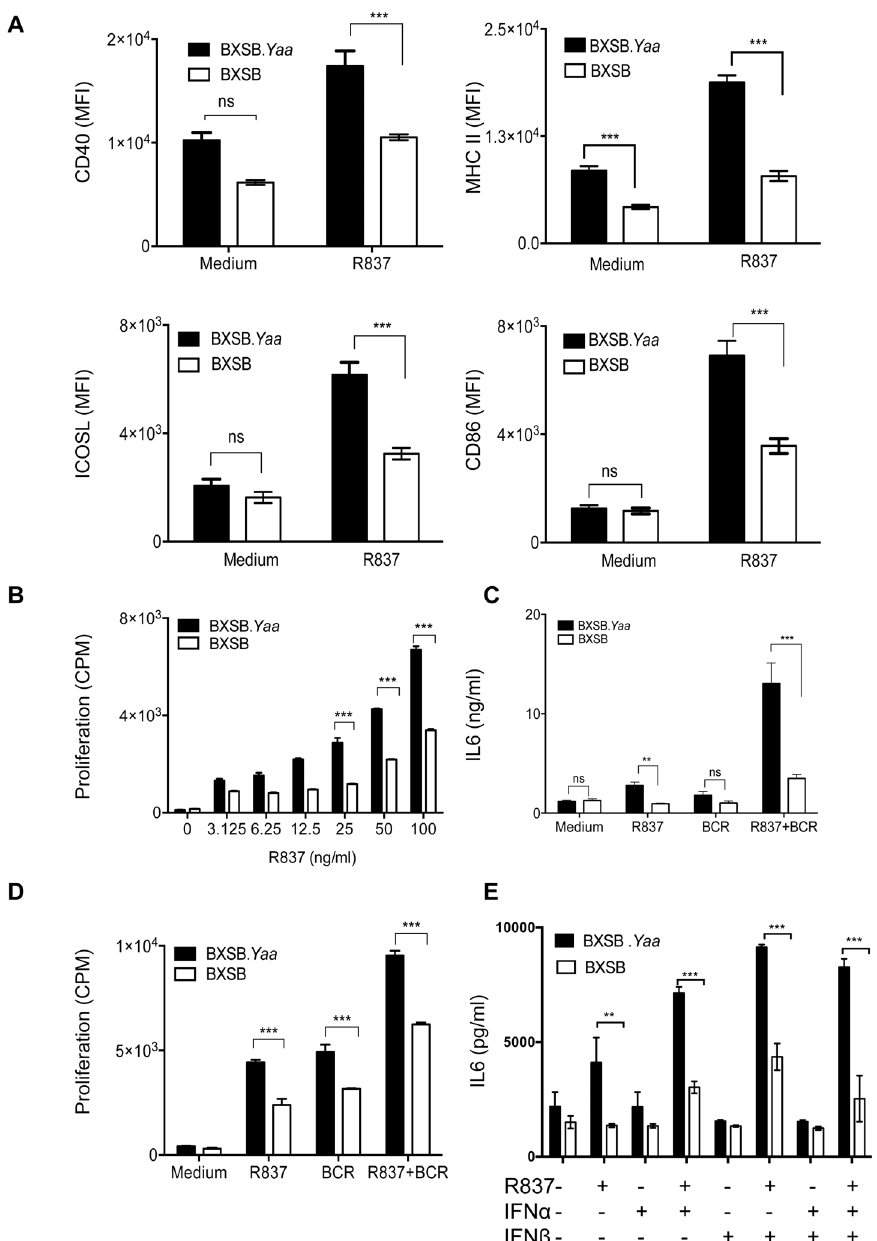
Fig 3. BXSB. Yaa B cells exhibit an activated phenotype. (A) Purified CD43 - B cells from 4 – 5 month old BXSB. Yaa and BXSB mice were stimulated with R837 (50ng/ml) for 24 hours and stained for surface expression of the activation markers — CD40, MHCII, ICOSL and CD86. Data are expressed as mean ± SEM of mean fluorescence intensity (MFI) and are pooled from 4 – 5 independent experiments. (B) Purified CD43 - B cells from 4 – 5 month old BXSB. Yaa and BXSB mice were stimulated with graded doses of R837 for 24 hours. 3 H thymidine (0.5 μ Ci/well) was added and its incorporation was determined after 16 hours by liquid scintillation counting. Proliferation was determined as counts per minute (CPM). (C-D) CD43 - B cells were stimulated with R837 (50ng/ml) in the presence and absence of anti-BCR antibody. IL6 secretion (C) and B cell proliferation (D) were determined as described earlier. (E) Purified B cells from 4 – 5 month old BXSB. Yaa and BXSB mice were cultured in the presence or absence of R837 (50ng/ml); IFN α and IFN β (40U/ml), either alone or in combination, for 24h. Supernatants were collected and quantified for IL6 levels by standard sandwich ELISA. All data (B-E) are expressed as mean ± SEM of triplicate wells and are representative of 2 – 3 independent experiments. P values are determined by two-way ANOVA. * p < 0.05, ** p < 0.01, *** p <